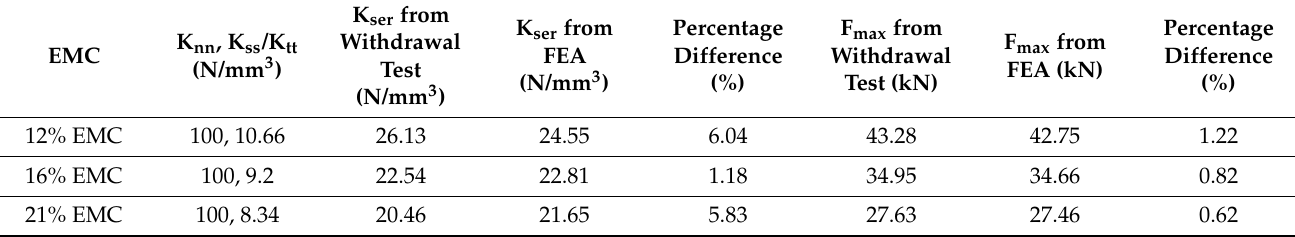
Table 14. 130 × 260 mm Glulam calibrated values.